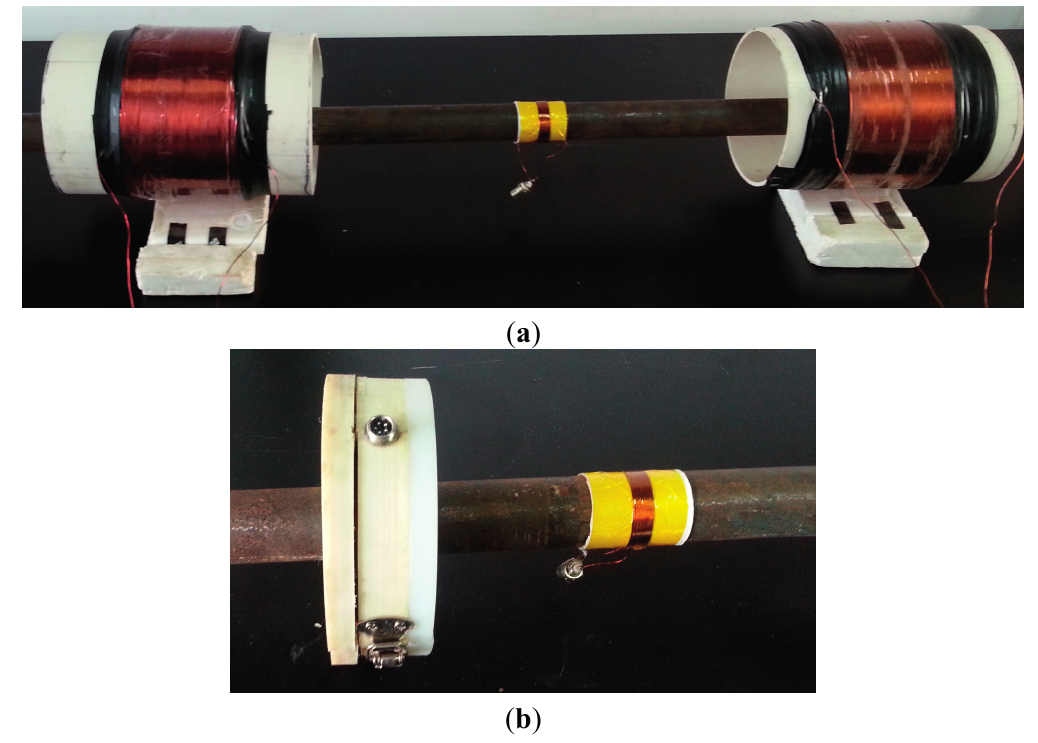
Figure 5. The photos of the prototype sensor for the pipe with a 38-mm outside diameter.